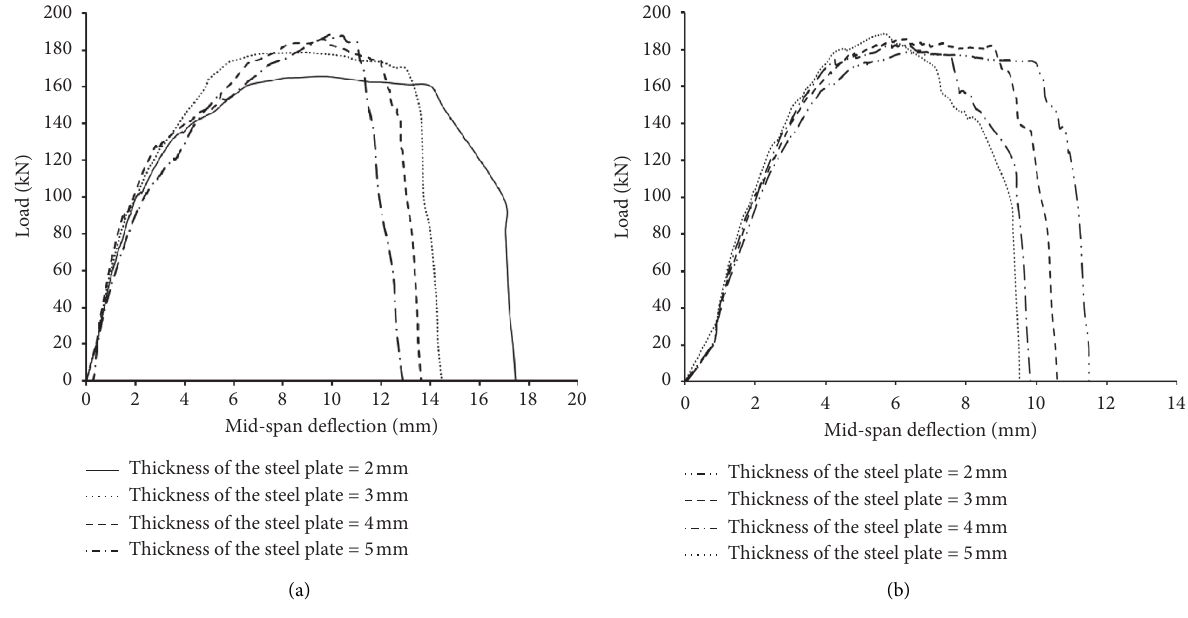
Figure 15: Load-deflection curves of beams S10C30 and SU10C30 strengthened by different thicknesses of the steel plate on the bottom surface: (a) beam S10C30 and (b) beam